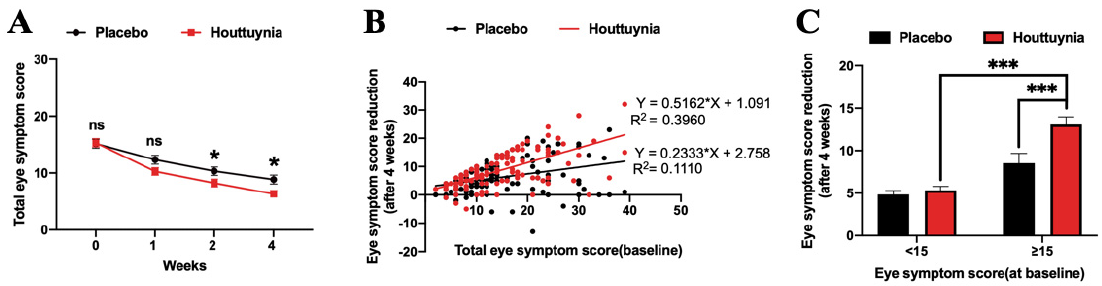
Figure 2. Change in eye symptom score. ( A ) shows eye symptom scores at baseline, one week, two weeks, and four weeks. ( B ) shows the linear correlation between decreases in eye symptom score after four weeks of treatment and scores at baseline. Points represent the values in this figure. The regression line equation and the correlation coe ffi cient R squared value are also shown in this figure. ( C ) highlights the reduction in eye symptom score after four weeks of therapy in scores < 15 and ≥ 15 (at baseline) in two subgroups. Data are presented as mean ± standard error of the mean (SEM). * p < 0.05, *** p < 0.001. ns, no significance. Table 1. Changes in eye symptoms and signs parameters after 4 weeks of treatment. Placebo ( N = 120 ) Houttuynia ( N = 118 ) p Value for After Variables Baseline